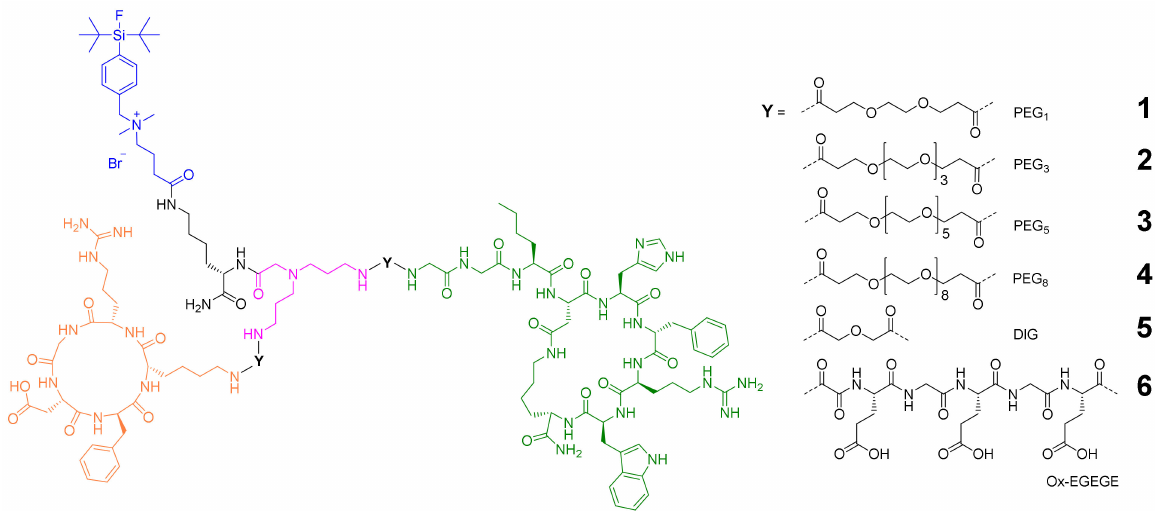
Figure 2. Depiction of the structures of the target HBPLs 1 – 6 consisting of: a SiFA lin -moiety ( blue ); a short lysine linker ( black ); the symmetrically branching framework ( pink ); linkers Y of different lengths and compositions (PEG 1 , PEG 3 , PEG 5 , PEG 8 , DIG, Ox-EGEGE; PEG = polyethylene glycol; DIG = diglycolic acid; Ox = oxalic acid); the MC1R- and integrin α v β 3 -affine peptides GG-Nle-c(DHfRWK) ( green ) and c(RGDfK) ( orange